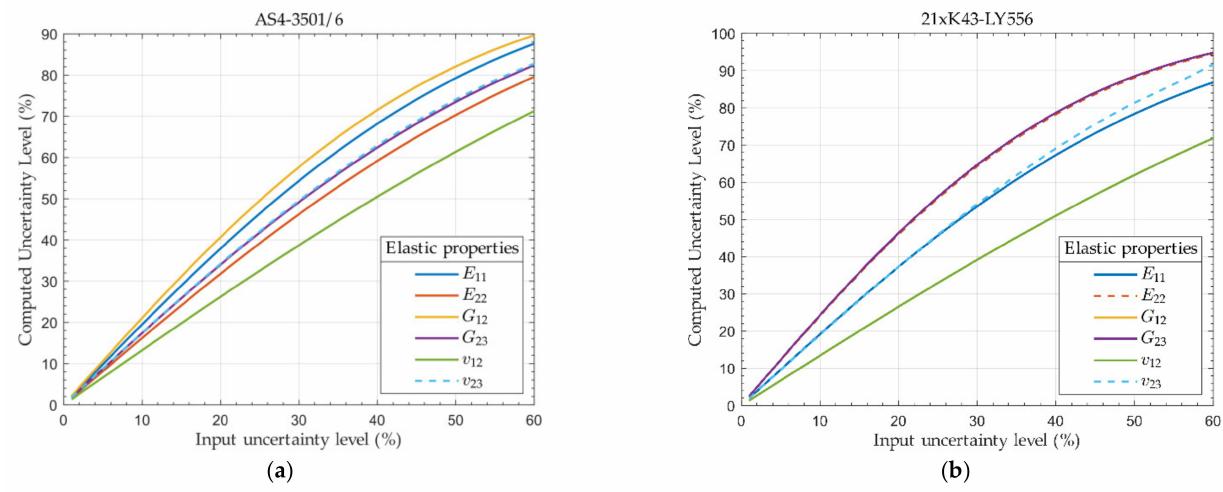
Figure 1. Output uncertain level versus input level for ( a ) AS4-3501/6 and ( b ) 21xK43-LY556 com- posite ply.